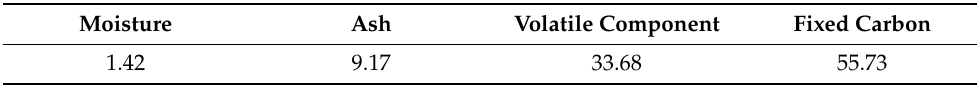
Table 4. Results of industry analysis on bituminous coal Table 3. Results of sulfur phase analysis on cyanide tailings.